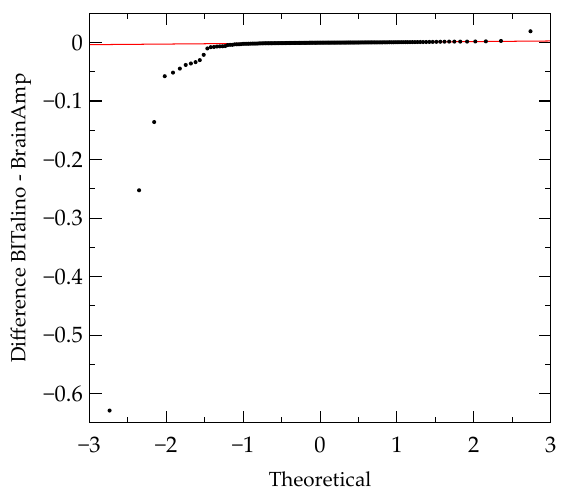
Figure 3. Q-Q plot of differences between the BrainAmp and the BITalino for LF. In the Q-Q plot, it can be seen that there were several outliers, which may have negatively affected the results of the normality test. Therefore, outliers were excluded and tested again for normality. In some measurements, more than half of the data points had to be excluded to reach normal distribution. However, this heavy reduction of data points may distort the results. According to Bland and Altman [40] (p. 139), a non-normal